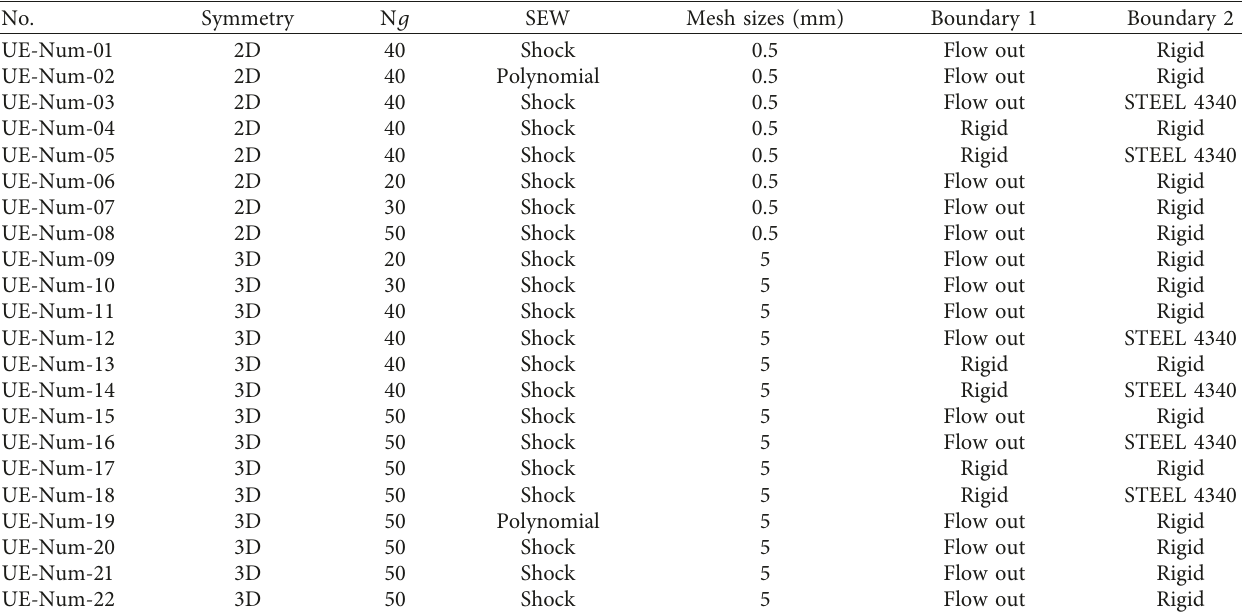
Table 3: Scheme of numerical